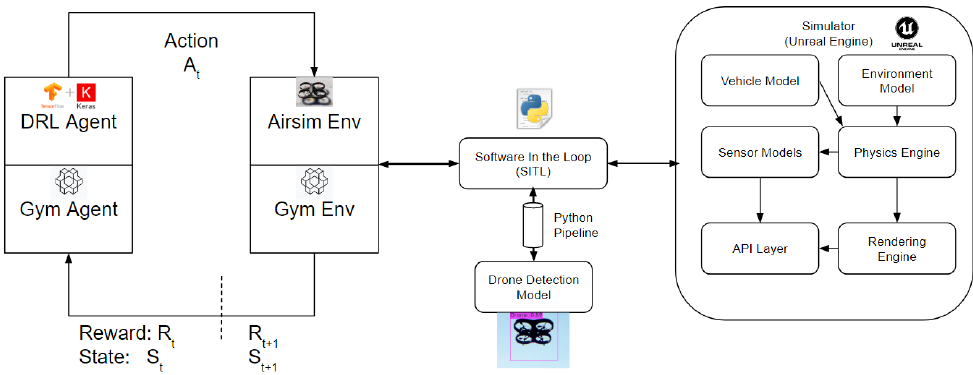
Figure 7. Experimental Setup. Table 3. Setup DRL